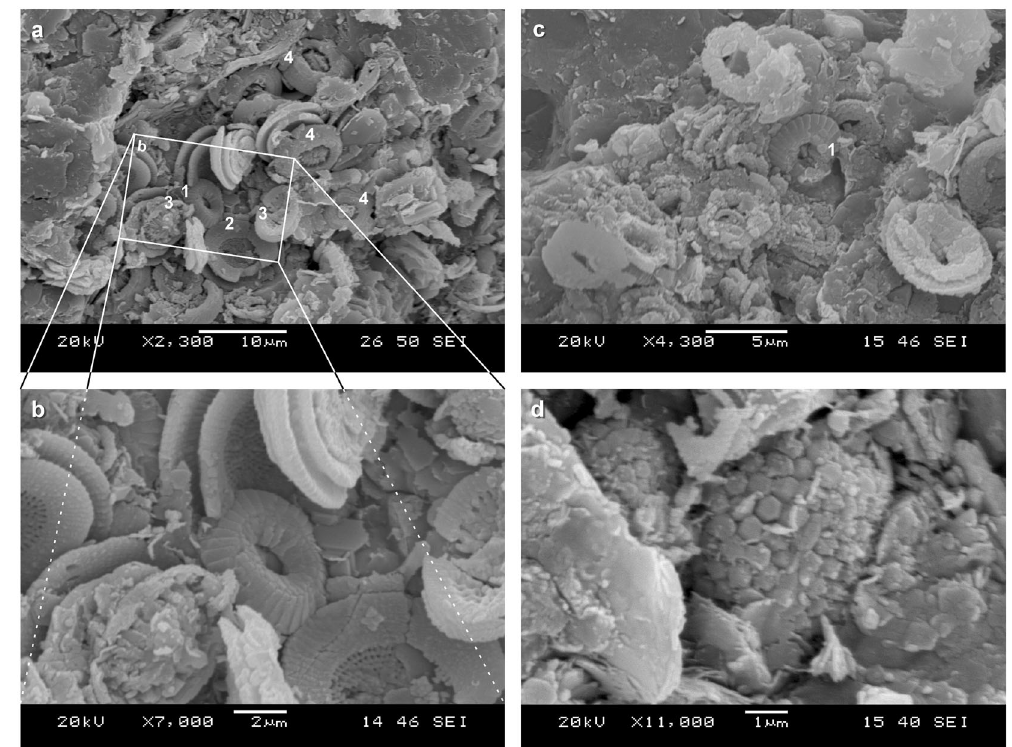
Fig. 4 SEM photos of calcareous nannofossils at Necroteuthis gladius level. a – c Partly exposed nannoplankton accumulation with well-preserved coccoliths. a — general view. b Detail: a — C. pelagicus , b — R. umbilicus (probably part of coccosphaera), c — Pontosphaera enormis , and d — R. ornata . c Corroded and recrystallized undeterminable calcareous nannoplankton with exception of dissolution-resistant C. pelagicus ( a ). d Framboidal pyrite as indicator of bacterial activity in dysoxic sediment.